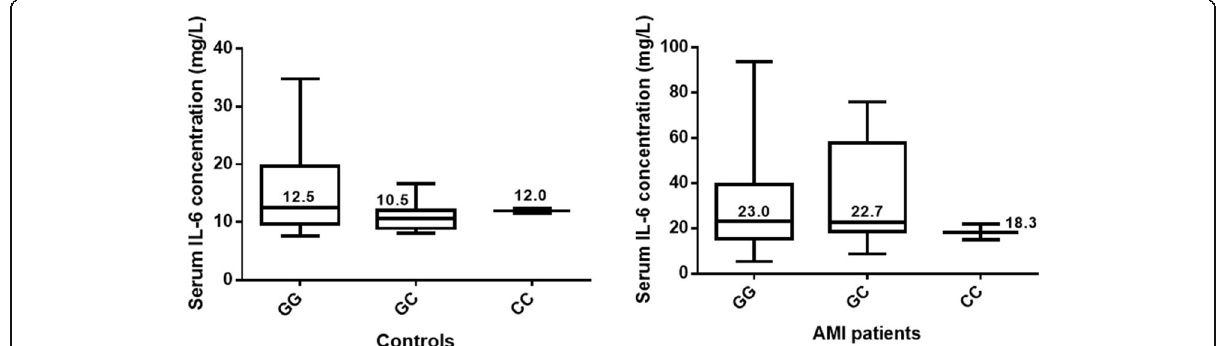
Fig. 6 Boxplots showing serum median and interquartile levels (25th and 75th) of IL-6 concentration among different genotypes in controls and AMI